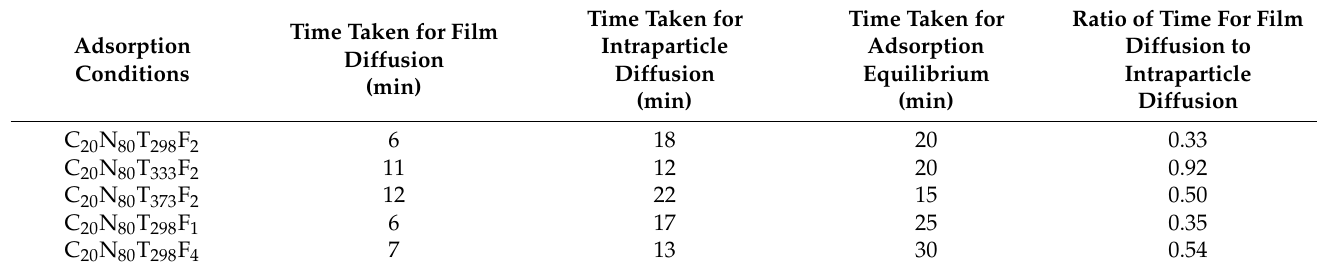
Table 6. The time taken for three stages of CO 2 adsorption from CO 2 /N 2 gas mixture.